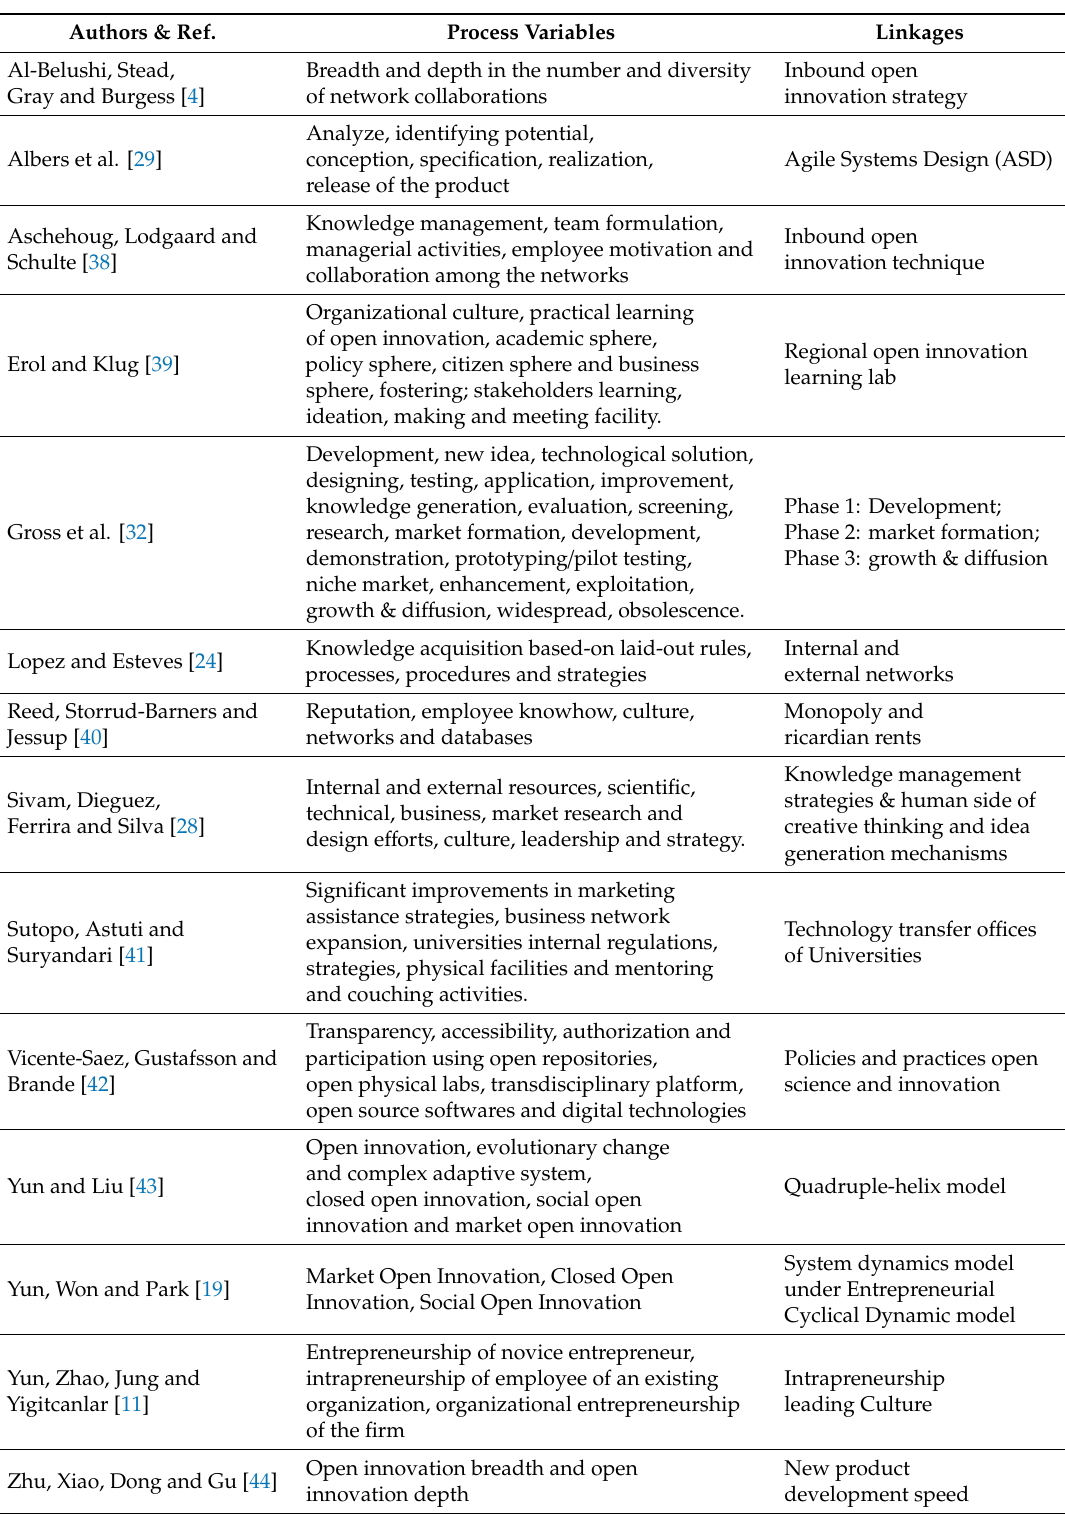
Table 2. Innovation processes and